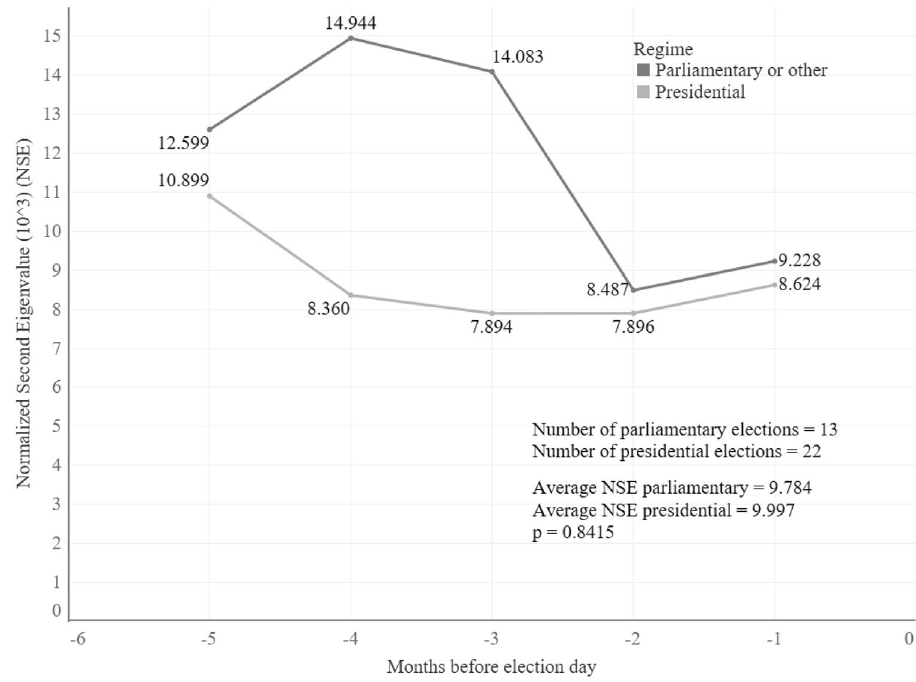
Figure 5. Evolution of the second eigenvalue according to the political regime. Since the normalized second eigenvalues do not have a normal distribution (its Kolmogorov–Smirnov test statistic (D) is 0.1951), a Mann– Whitney U Test was performed to determine if the differences between the means were statistically significant.